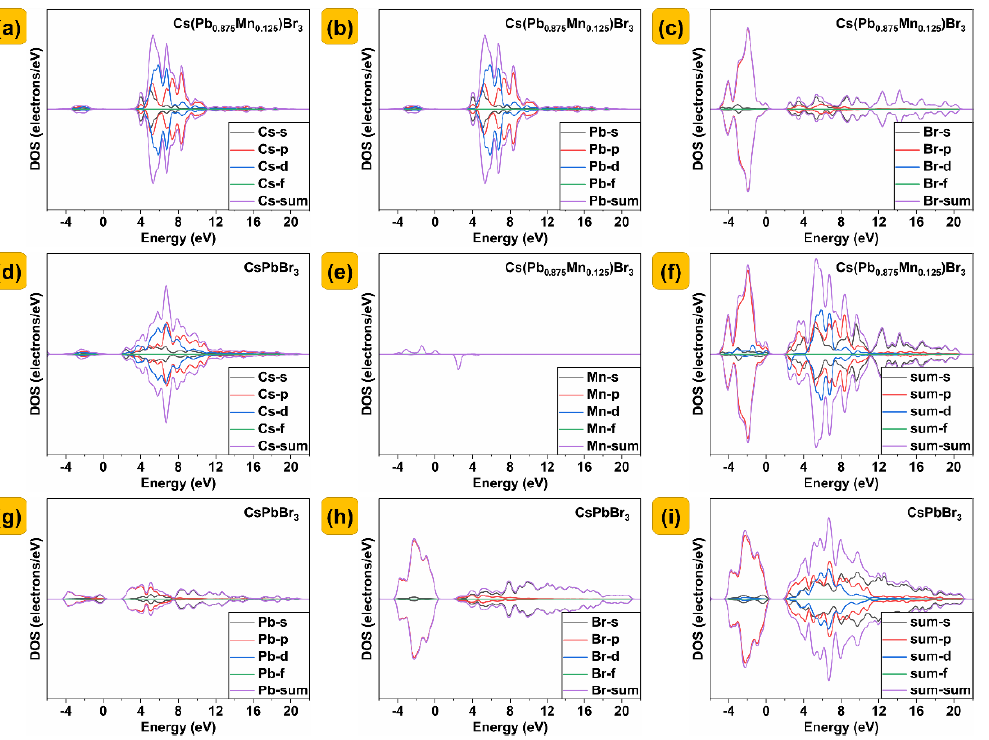
Figure 6. Detailed partial density of states of CsPbBr 3 and Cs(Pb 0.875 Mn 0.125 )Br 3 . ( a , b , c , e , f ) Partial density of states of Cs(Pb 0.875 Mn 0.125 )Br 3 . ( d , g , h , i ) Partial density of states of CsPbBr 3 .